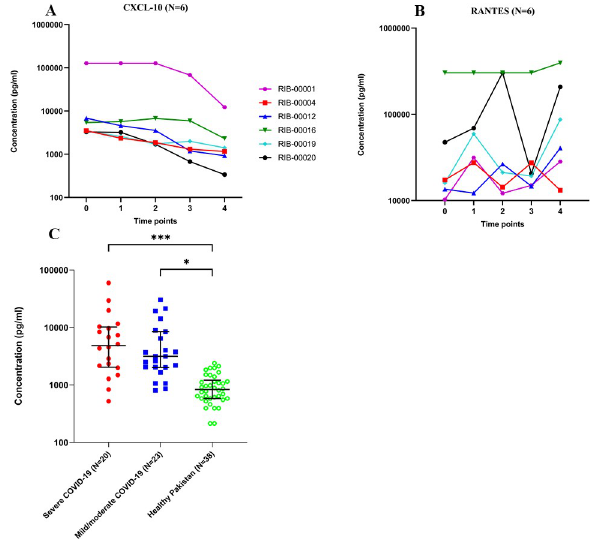
Fig 6. Dynamics of cytokines/chemokines in COVID-19 patients. Plasma concentrations (pg/mL) of (A) CXCL-10 and (B) RANTES in six COVID-19 patients from USA were detected by multiplex microbead assay. Estimated time (8–16 days) from the onset of symptoms (as reported by patients) is shown; (C) CXC-L10 in 43 COVID-19 patients from Pakistan. Concentration (pg/ml) and Interquartile Range (IQR) are shown, and the P values by one-way ANOVA and Tukey’s multiple comparison test between the groups are as follows: � p < 0.05, ��� p <